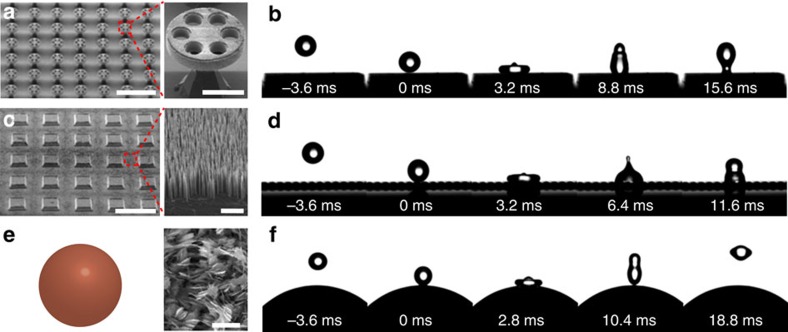
Liquid curvature effect on breakdown of superhydrophobic-like bouncing.(a) Scanning electron microscopic (SEM) image of as-fabricated circular mushroom post arrays (left panel, scale bar, 300 μm). The radius, centre-to-centre spacing, and height of mushroom post are 47, 200 and 85 μm, respectively. The entire surface was covered by silicon nanowire (right panel, scale bar, 50 μm) and infused with a thin layer of lubricating oil. (b) Selected snapshots showing the breakdown of superhydrophobic-like bouncing on oil-infused mushroom structure due to easy penetration of droplet into post arrays. (c) SEM image of silicon pyramid arrays with two-tier roughness (left panel, scale bar, 750 μm). The edge size, centre-to-centre spacing and height of pyramids are 300, 800 and 75 μm, respectively. The entire surface was decorated with silicon nanowire (right panel, scale bar, 50 μm) and infused with a thin layer of lubricating oil to form liquid curvature. (d) Selected snapshots showing the breakdown of the superhydrophobic-like bouncing on liquid-infused pyramid arrays. (e) Schematic diagram of as-fabricated copper ball (left panel) with a radius 10 mm decorated with CuO nanoblade (right panel, scale bar, 2 μm) for oil infusion. (f) Selected snapshots showing the droplet impacting on liquid-infused spherical surface. The droplet bouncing was found to be close to that on flat thin film.